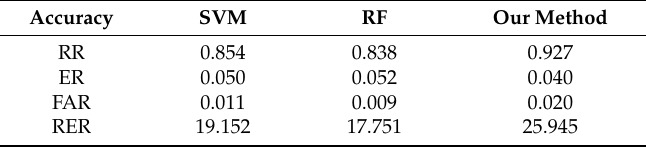
Table 5. Cloud detection accuracy for SVM, RF and our proposed method with GF-1.